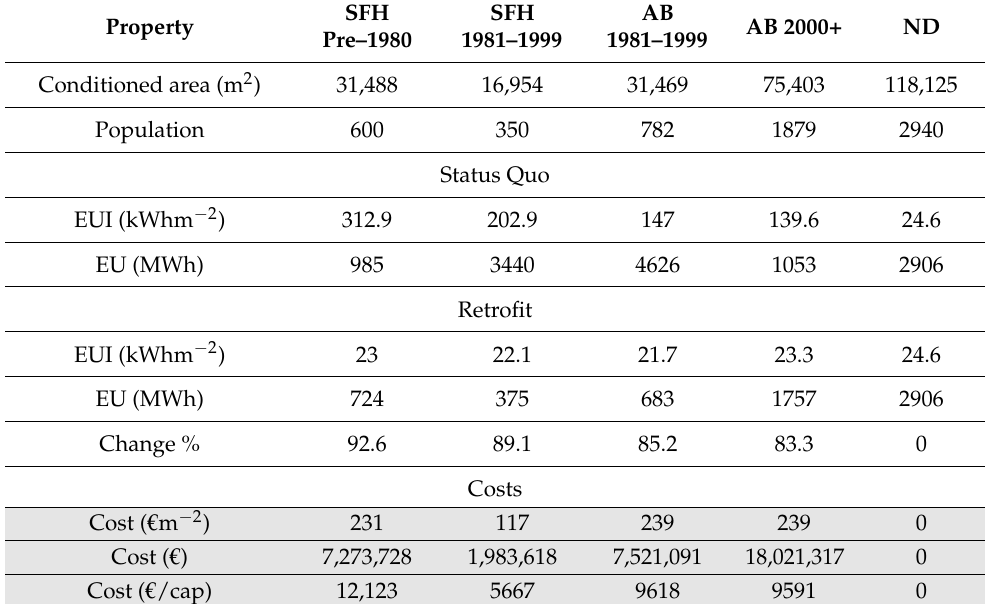
Table 4. The estimated cost and impacts of retrofits by dwelling age and